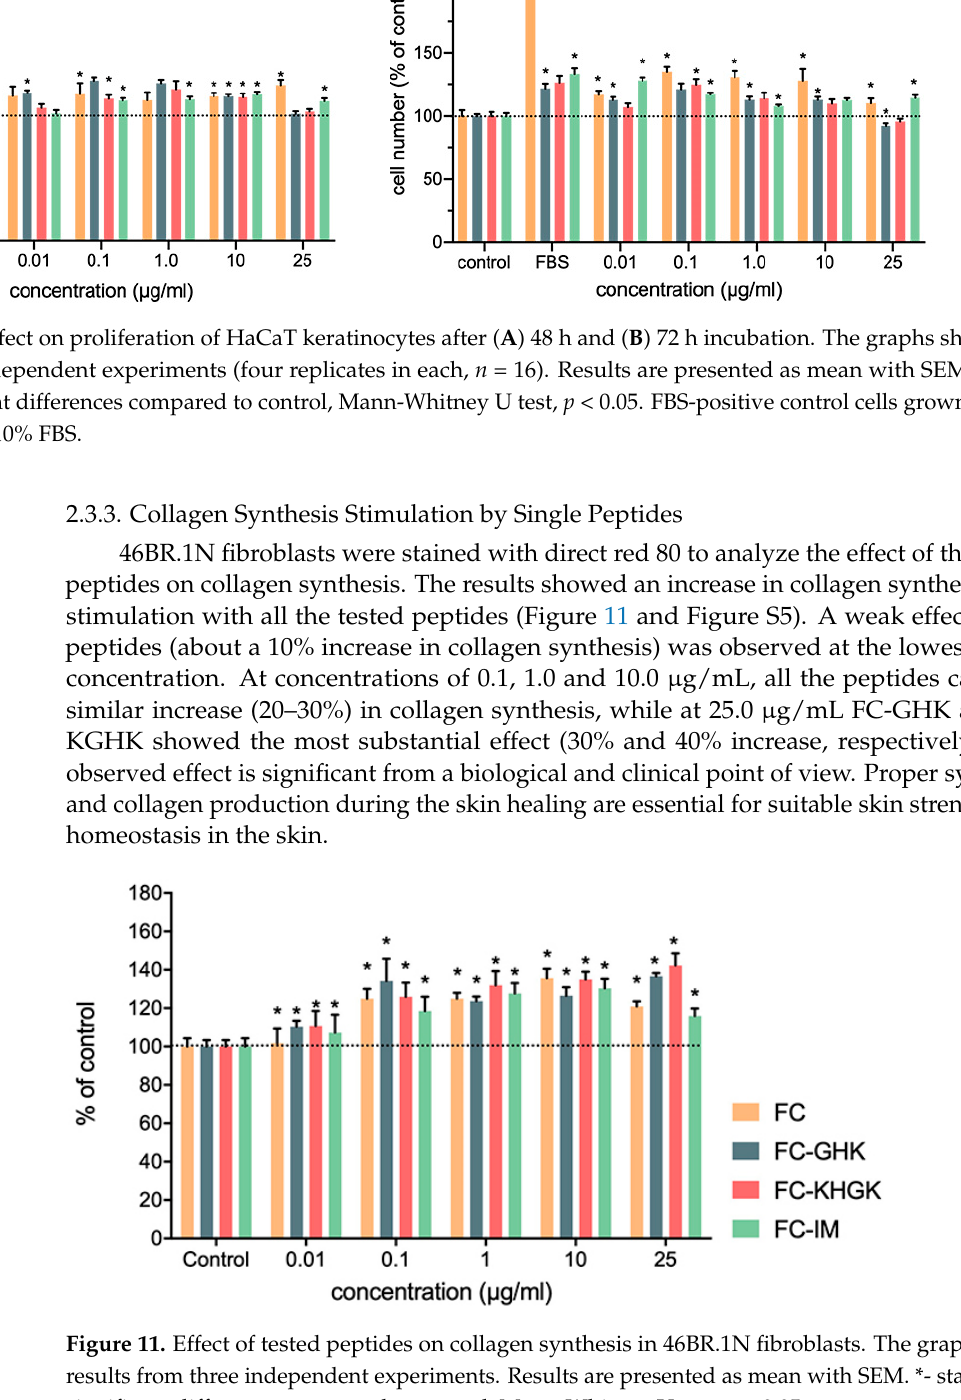
Figure 9. Peptide effect on proliferation of 46BR.1N fibroblasts after ( A ) 48 h and ( B ) 72 h incubation. The graphs show results from four independent experiments (four replicates in each, n = 16). Results are presented as mean with SEM. *- statistically significant differences compared to control, Mann-Whitney U test, p < 0.05. FBS-positive control cells grown in a medium containing 10% FBS.